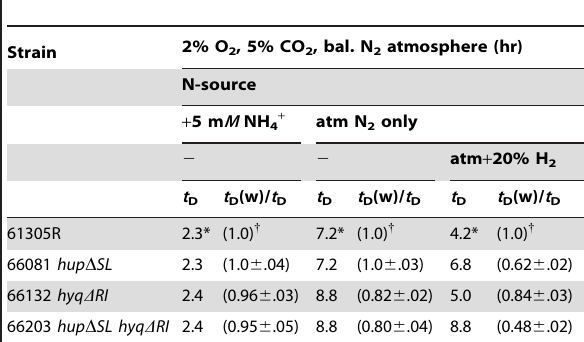
Table 2. Exponential growth rates of A caulinodans strains in diazotrophic liquid batch cultures at 29 u